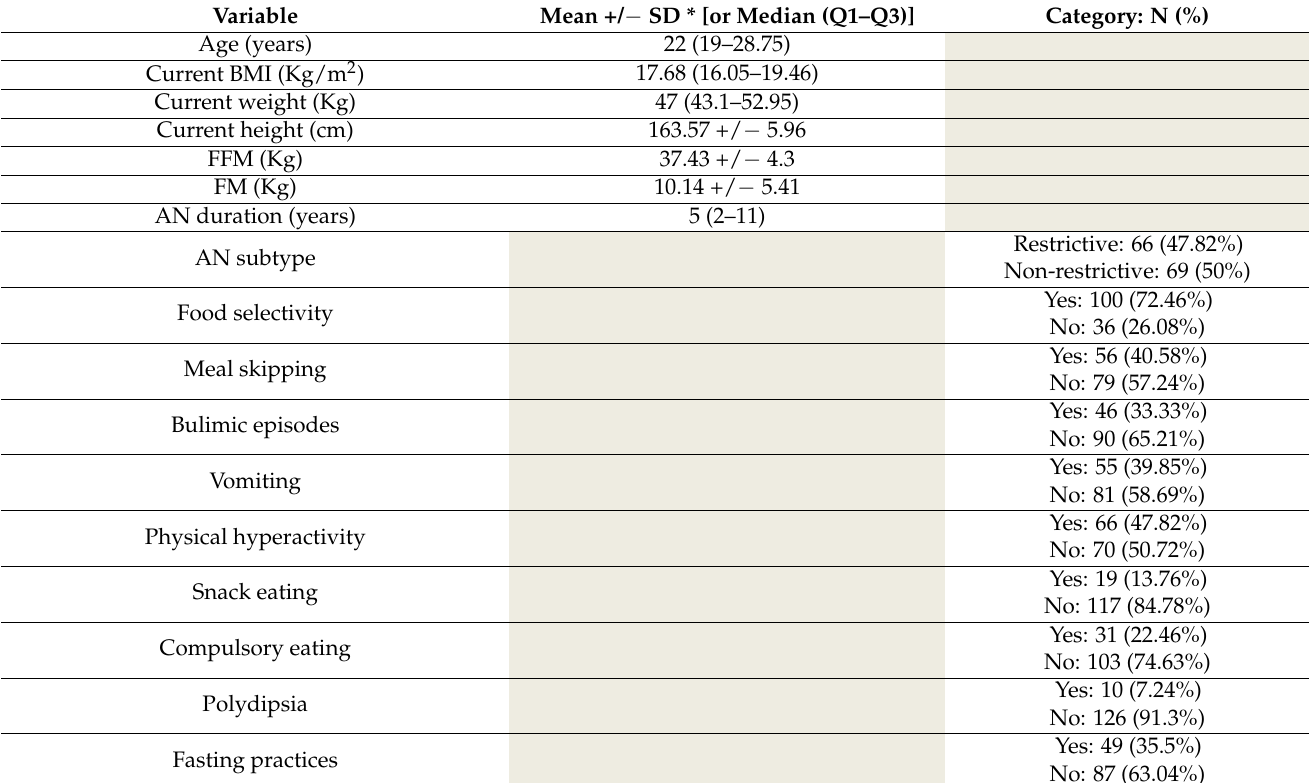
Table 1. Descriptive analysis of the variables assessed in the study